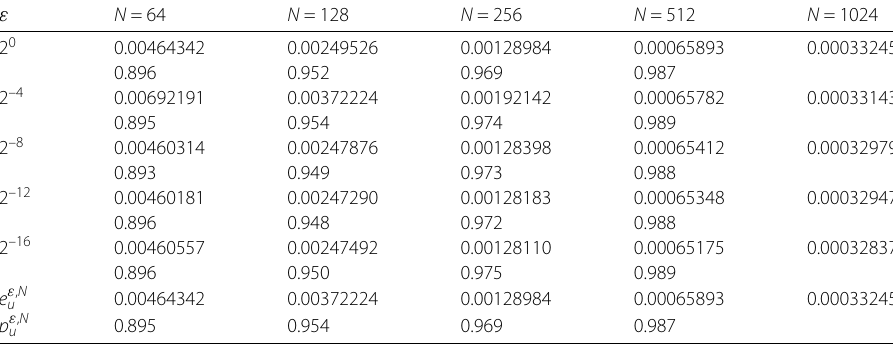
Table 2 Errors e ε , N